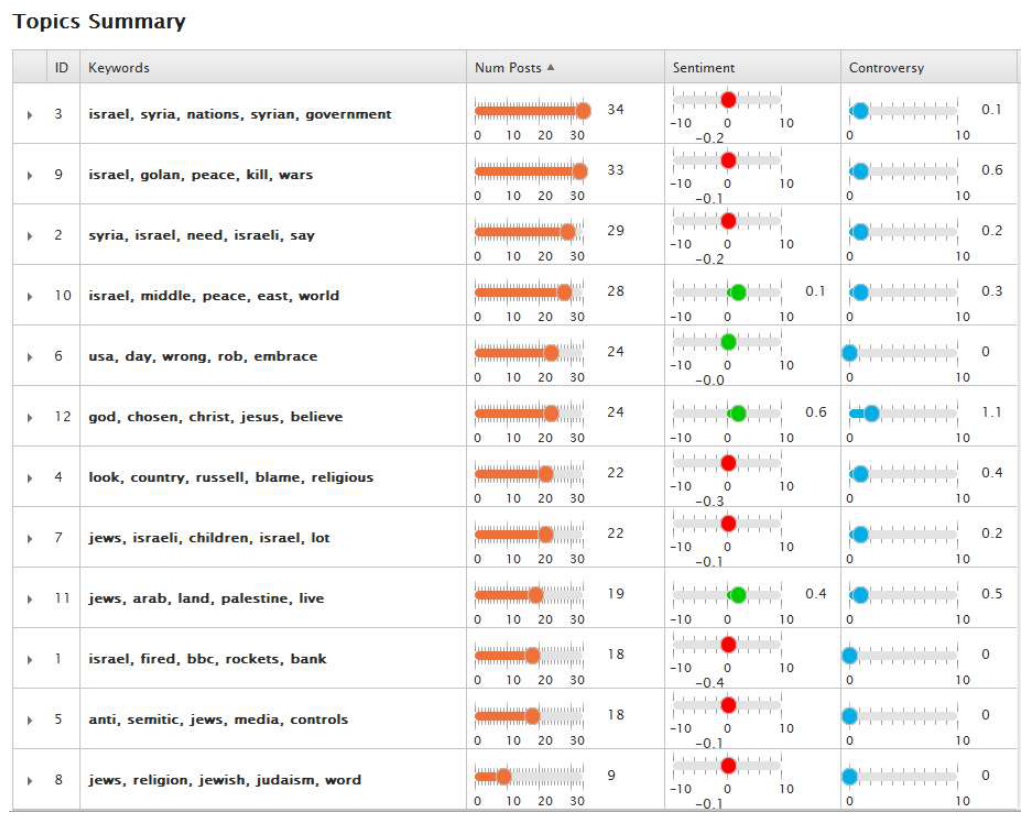
Figure 12: Topic Analysis for Posts and Comments in Table 1 Each line includes a list of five keywords that build the topic (e.g. “israel”, “Syria”, “golan”, “trying”, “rebels”). The next column shows the number of tweets that are sorted to each topic (e.g. 34 tweets for the first topic). The last two columns show the sentiment and controversy of tweets that are measured for each of the twelve topics. The indication of sentiment shows if the tweets that are related to one topic are rather positive, neutral or negative. The indication of controversy shows the ratio of positive and negative posts.